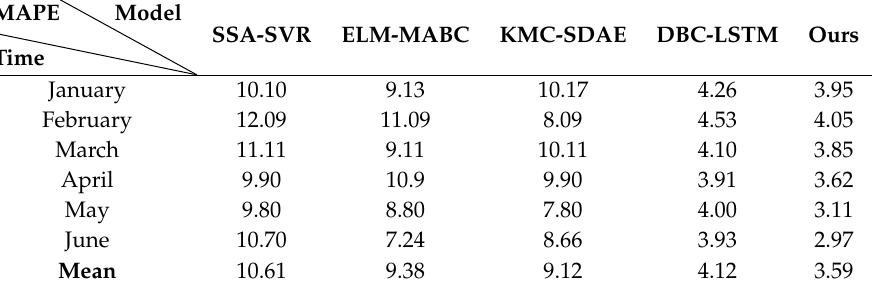
Table 4. Forecast errors of different models.